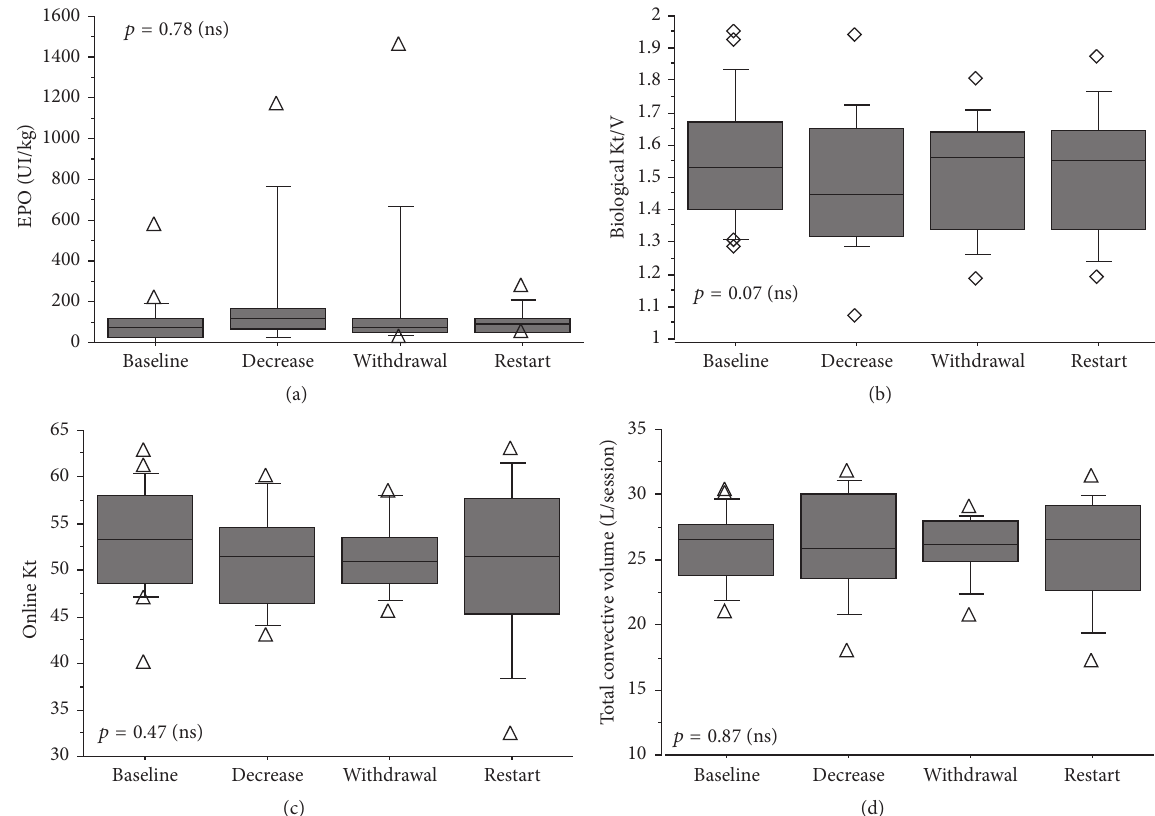
Figure 1: Comparison between 4 periods in nadroparin use: at baseline, during nadroparin decrease, during withdrawal, and at restart for (a) erythropoietin (EPO) use ( 𝑝 = 0.78 (ns)), (b) biological Kt/V according to Daugirdas 2 equation ( 𝑝 = 0.07 (ns)), (c) online Kt ( 𝑝 = 0.47 ), and (d) total convective volume ( 𝑝 = 0.87 ). 𝑝 values were estimated with Friedman